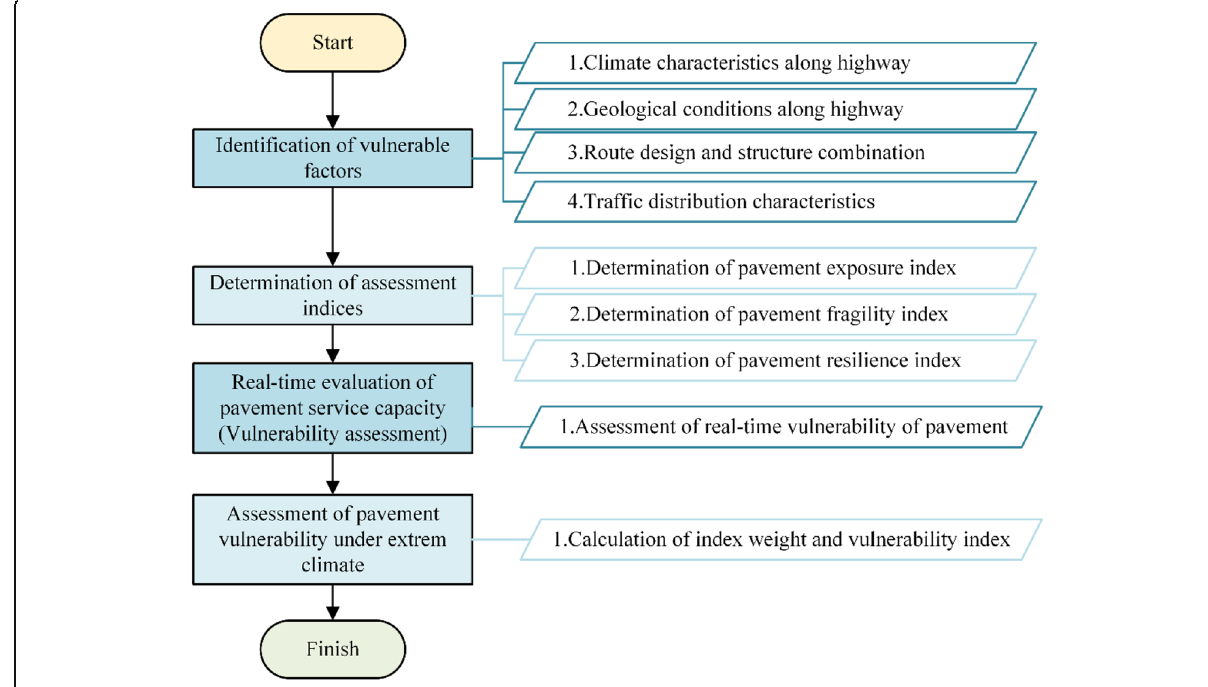
Fig. 3 Vulnerability assessment process of asphalt pavement in cold regions